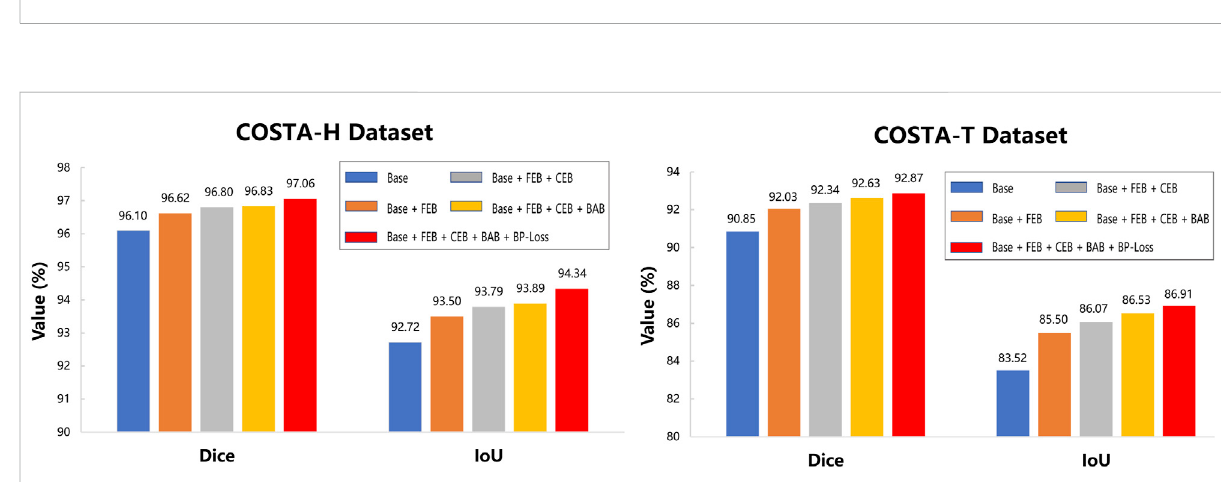
FIGURE 10 Ablation results on COSTA-H and COSTA-T datasets. The blue bars denote the quantitative results of the baseline network U-Net. The orange bars denote the segmentationresults ofthe network with FEB. The gray bars denote the segmentationresults of thenetwork with FEBand CEB. The yellow bars denote the segmentation results of the network with FEB, CEB, and BAB. The red bars denote the segmentation results of the network with FEB, CEB, BAB, and